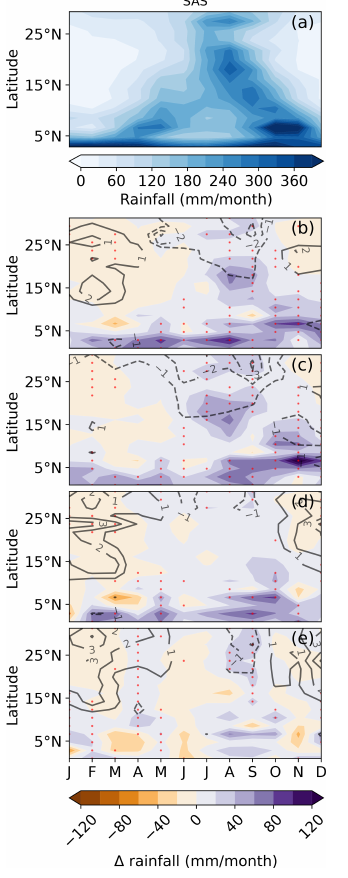
Figure 9. Hovmöller diagrams for the SAS domain. Panel (a) cor- responds to the precipitation values in millimetres per month over the historical period (1976–2005). All other diagrams correspond to the difference between the future scenario (2041–2070) and the his- torical period (1976–2005) for precipitation (colours) and (cid:49) MSE (black contours, dashed lines for negative values). Future scenarios are (c, d) RCP8.5, (e, f) WAIS3m, (g, h) GrIS1m and (i, j) GrIS3m. Significant differences at the 95% confidence interval are depicted by red dots according to the Wilcoxon–Mann–Whitney test (see Sect. 2.3).